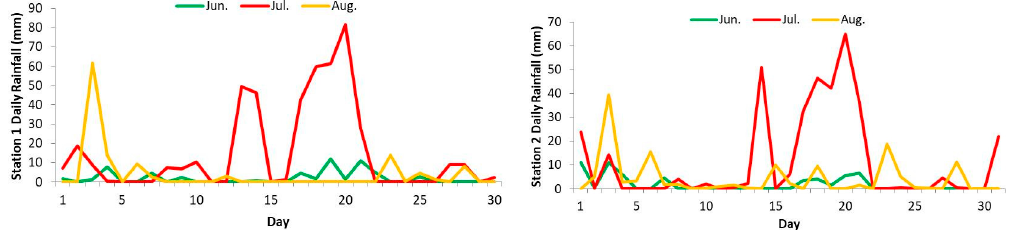
Figure 5. Daily rainfall data from June to August (2017) of the Jiaohe County weather stations.